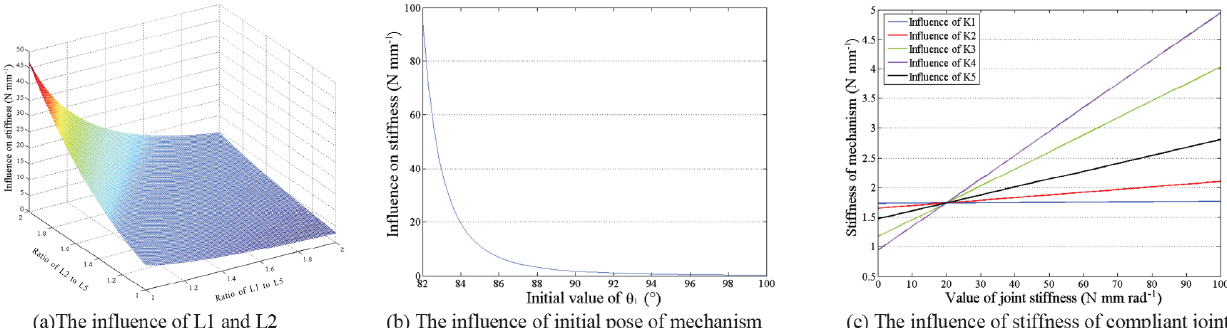
Figure 4. The influence of variables on mechanism stiffness.